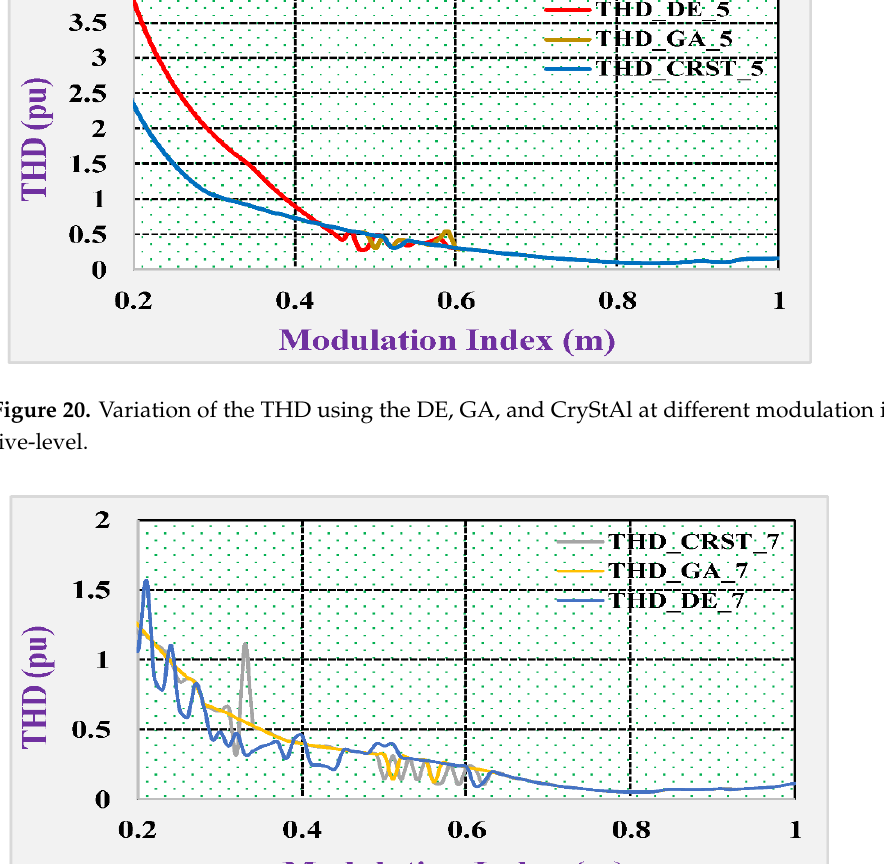
Figure 22. Variation of the THD using the DE, GA, and CryStAl at different modulation index for nine-level. 7. Hardware Implementation The simulation results have been experimentally validated in the laboratory on a single- phase cascaded H-bridge multilevel inverter prototype. Figure 23 shows the laboratory hardware setup consisting of two H-bridges which have been designed by employing 8 IGBTs (FGA25N120ANTDTU) with voltage & current ratings of 6000 Volts and 50 A re- spectively. The lower and upper H-bridge has been fed using asymmetrical confirmation